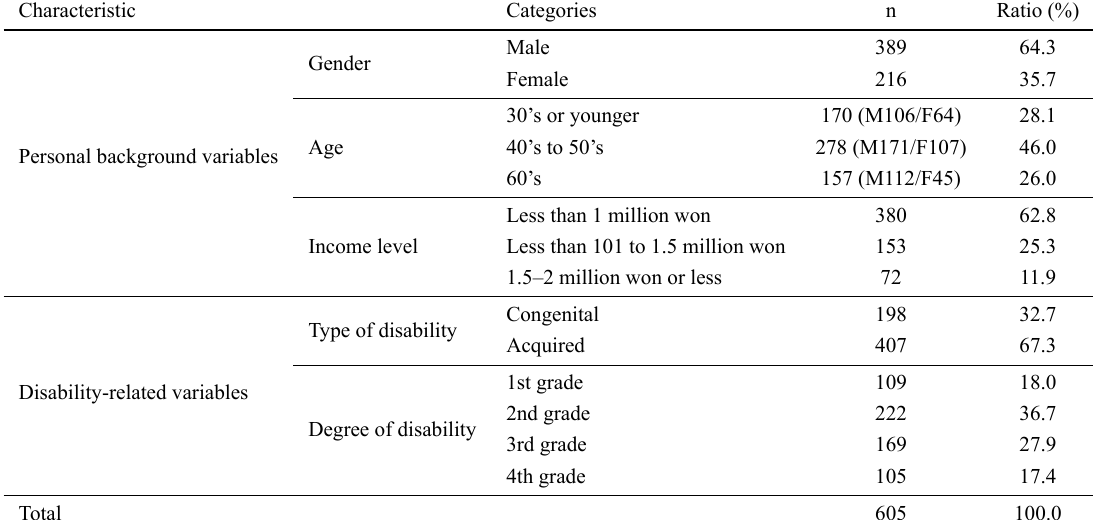
Table 1. General characteristics of